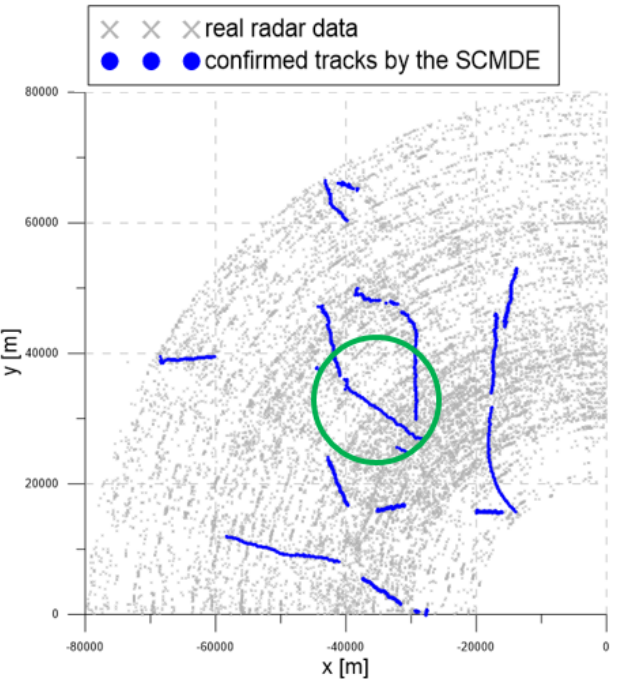
Figure 18. The trajectories of the confirmed tracks by using the